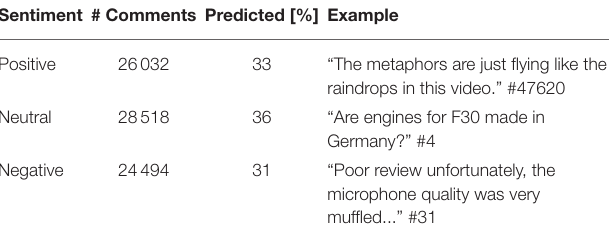
TABLE 2 | Example comments and sentiment distribution within the YouTube comments predicted by our developed sentiment model. Sentiment # Comments Predicted [%]